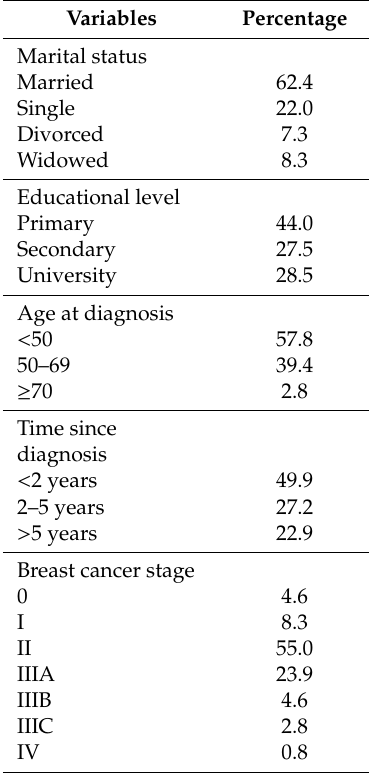
Table 1. Sample characteristics ( n =